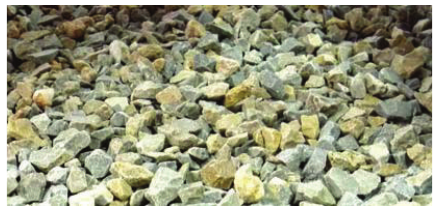
Figure 3: Crushed stones.